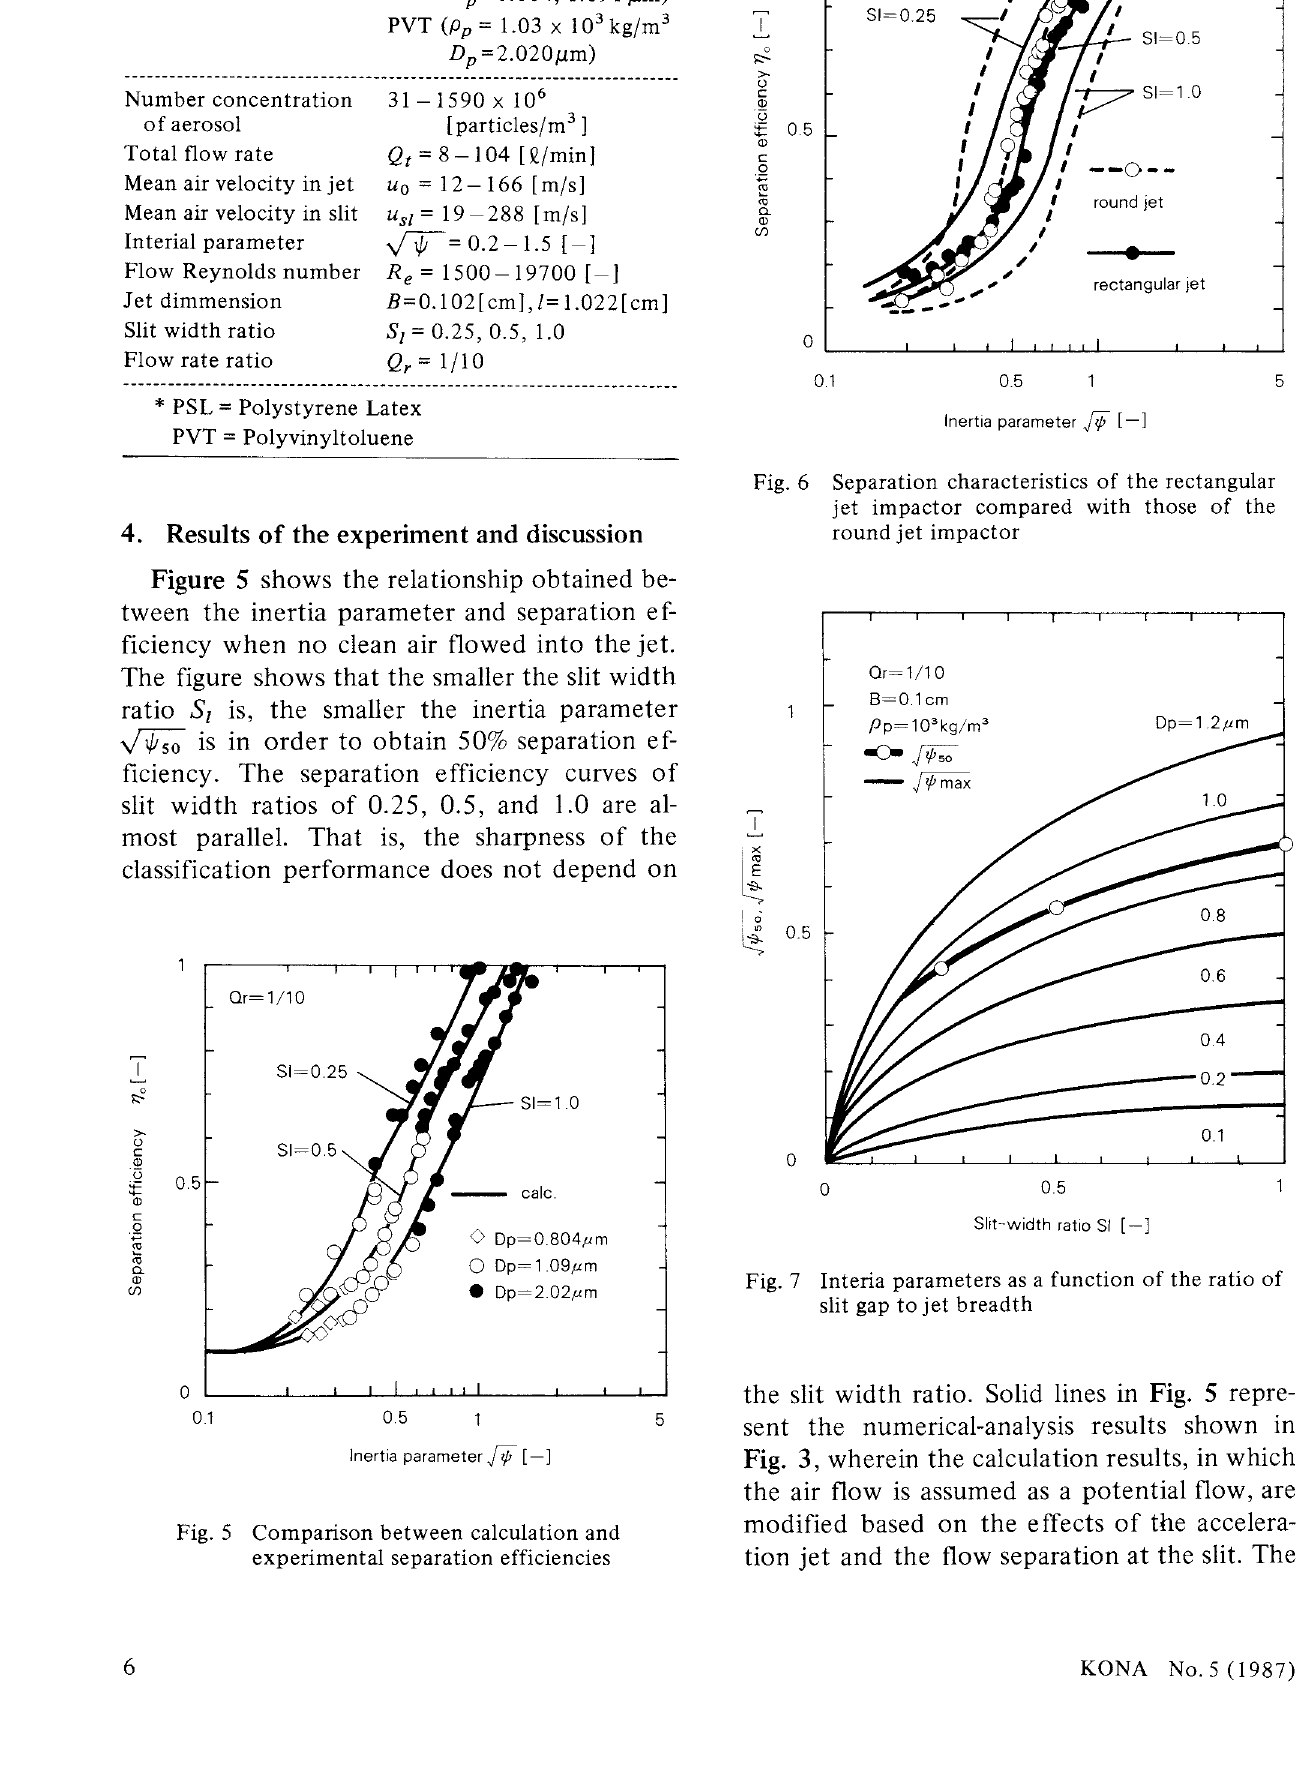
Table l Conditions of the experiment